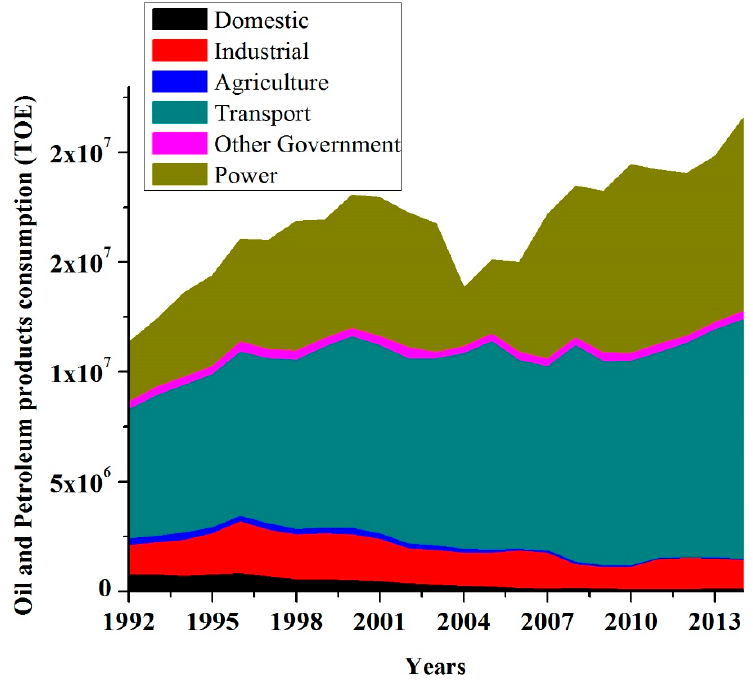
Figure 7. Oil and petroleum products consumption across various sectors